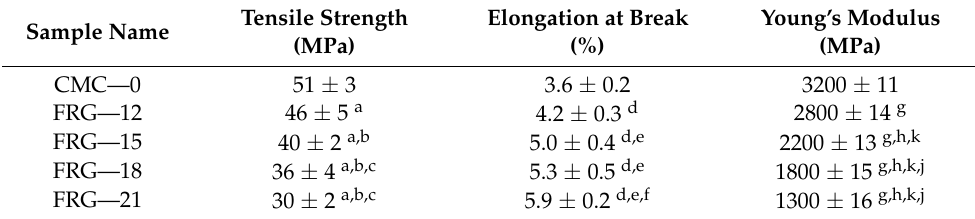
Table 2. Mechanical properties of sublingual films based on CMC with freeze-dried G. biloba extract (GFD).